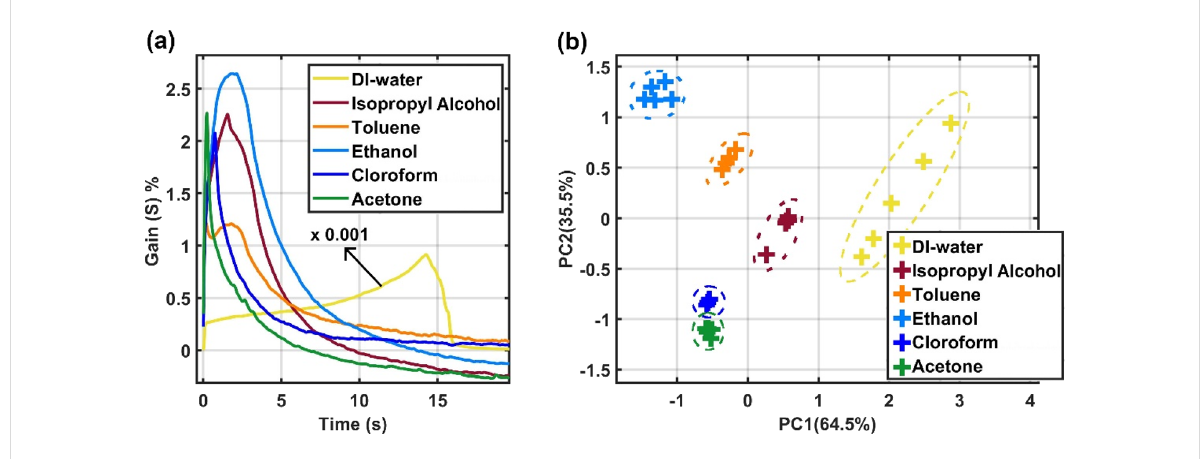
Figure 3: (a) Gain curves obtained from different organic solvents. (b) PCA analysis of organic solvents showing excellent distinction between the sample categories. In the case of DI water, a scale factor of (×0.001) was applied to the curve of Figure 3a to help visualization.